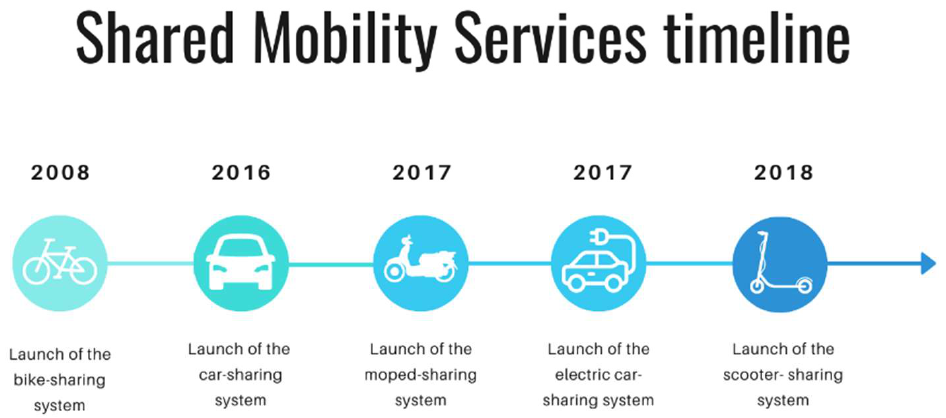
Figure 1. The timeline of shared mobility services in Poland.